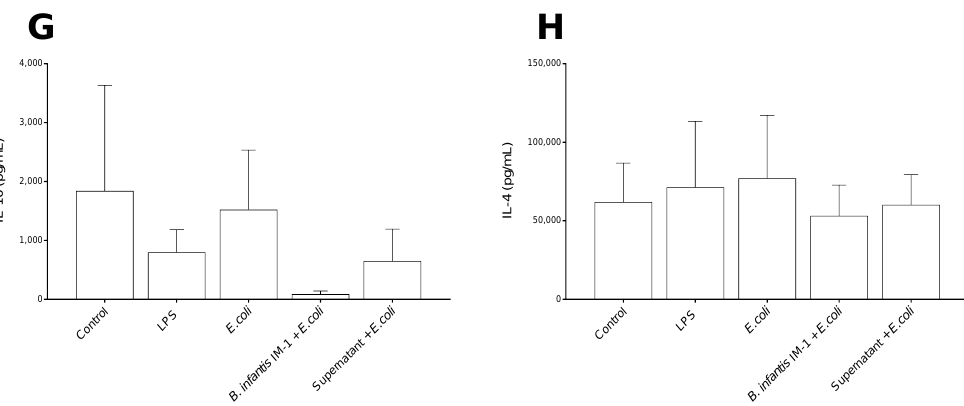
Figure 5. Cytokine levels in the culture medium of co-cultures of Caco-2 and DCs after 1 h of treatments. ( A ) IL-1 β . ( B ) IFN- γ . ( C ) IL-12 p70. ( D ) IL-6. ( E ) IL-8. ( F ) TNF α . ( G ) IL-10. ( H ) IL-4. Results are expressed in pg/mL as the mean ± SEM of three independent experiments. * p < 0.05 vs. control (untreated cells); # p < 0.05 vs. LPS.